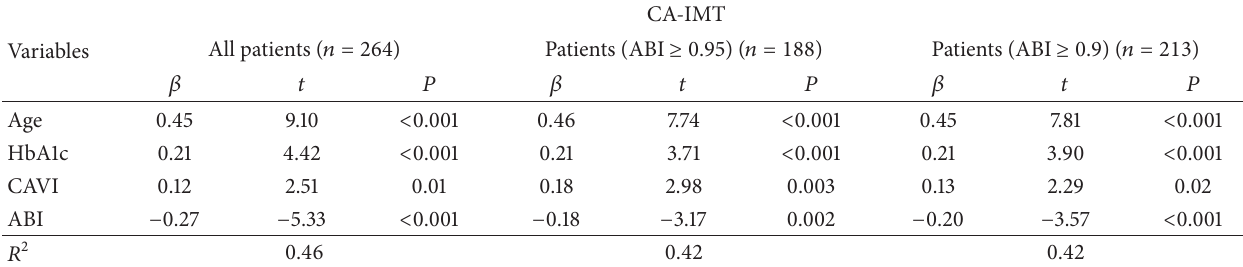
Abbreviations used in this table are the same as in Table